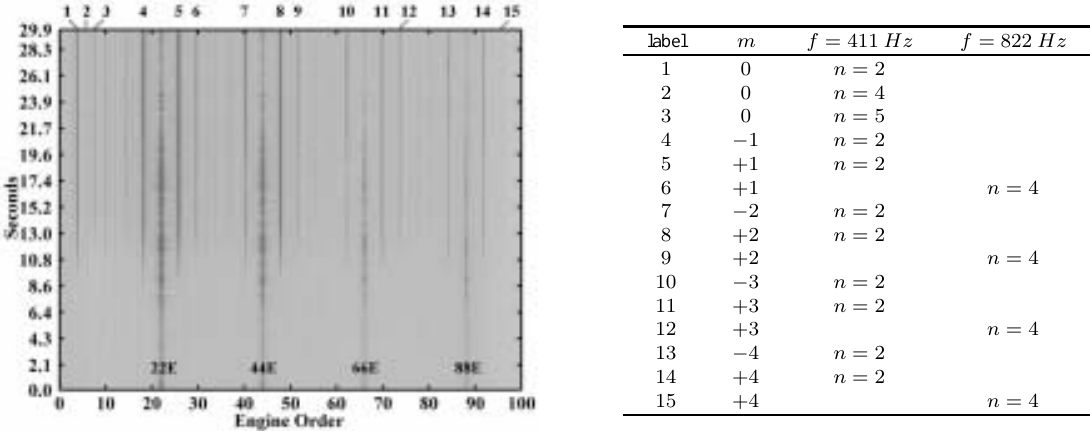
Fig. 6. Top down view of Fig. 5 with the major wave harmonics and nodal diameters